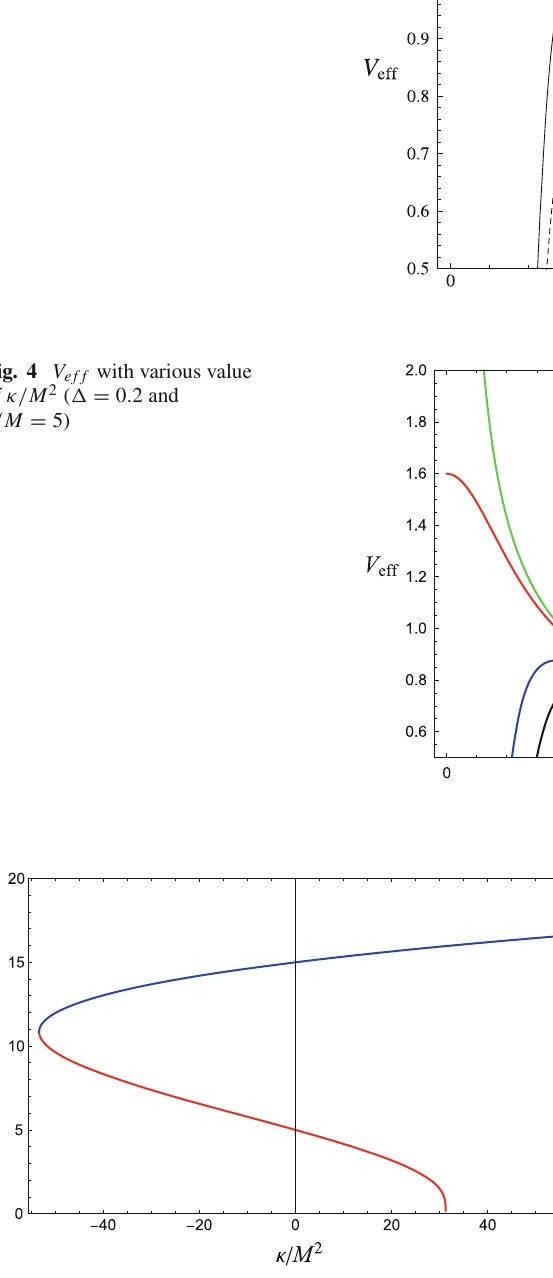
Fig. 5 extrema of V ef f as a function of κ/ M 2 with (cid:19) = 0 . 2 and (cid:21)/ M = 5